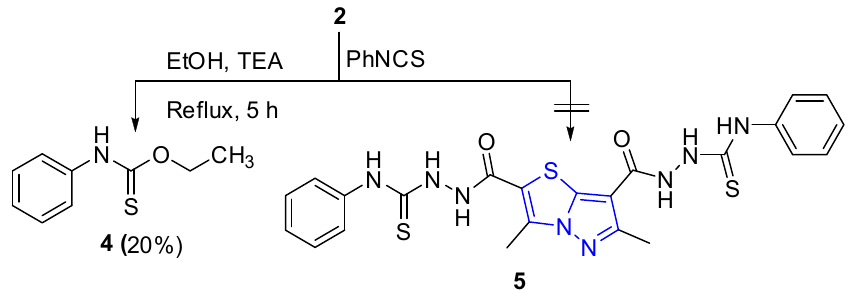
Scheme 2. Unexpected synthesis of O -Ethyl N -phenylcarbamothioate ( 4 ).